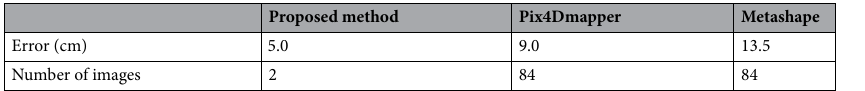
Table 5. Comparison between the proposed method and the two conventional methods in the second experiment.